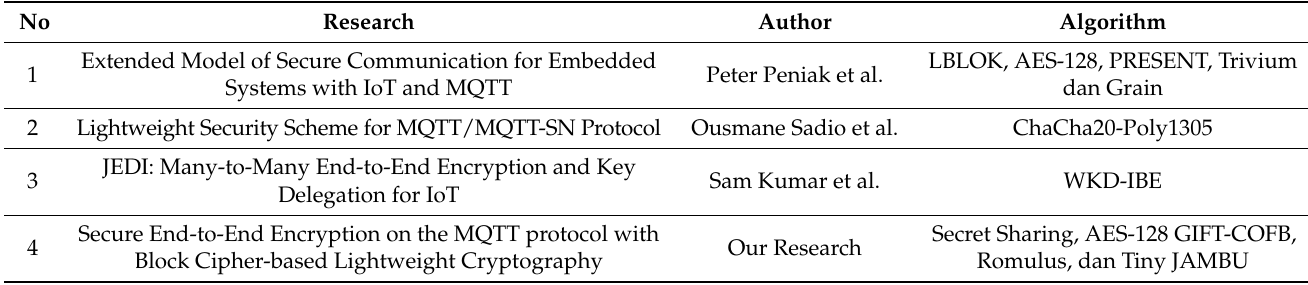
Table 1. Comparison with Previous